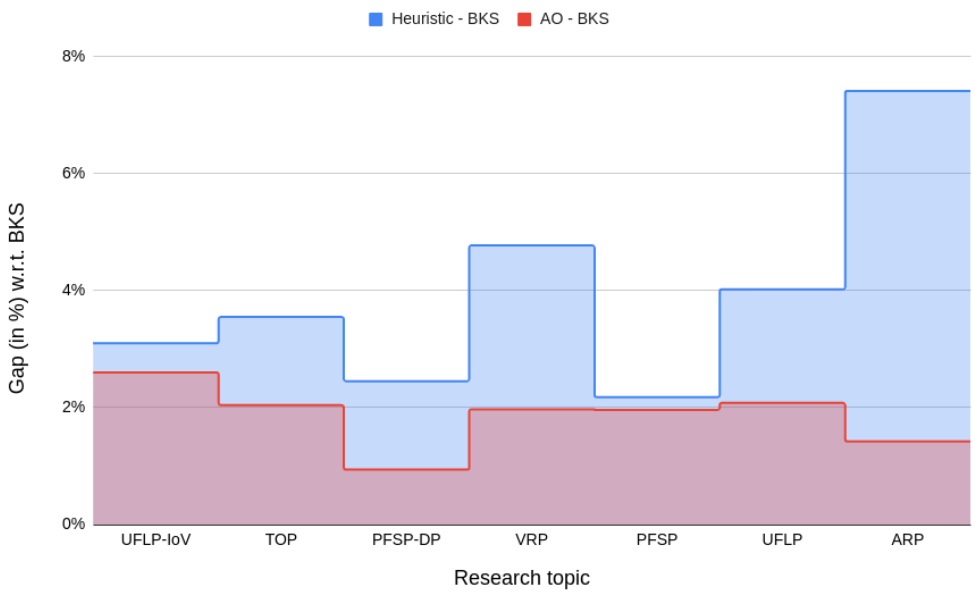
Figure 6. A comparison of AO performance for different research